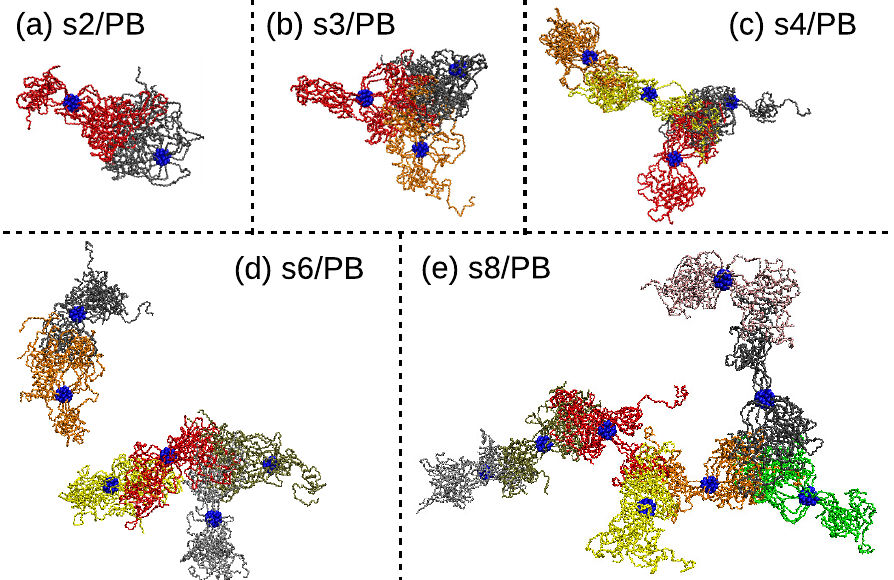
Figure 5. Randomly selected snapshots of the PEO domains aggregated in the macrostructure in stars are painted with different colors, and the central dendritic structure of each star is depicted with blue